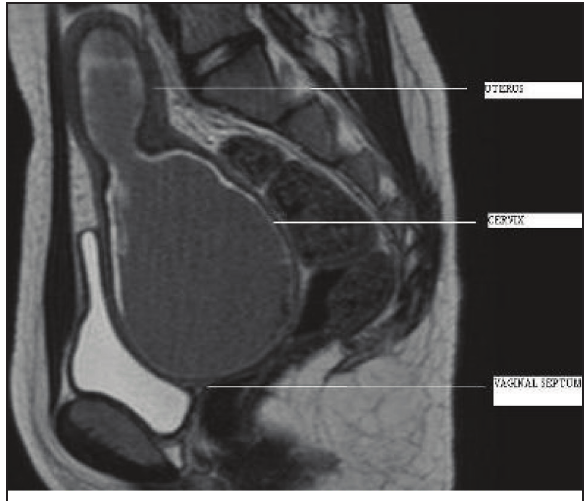
Figure 1. Prior to first surgery MRI film: uterus with haematometra, dysgenetic cervix, -which is ballooned up, non canaliza tion of cervical os, and a transverse vaginal septum.